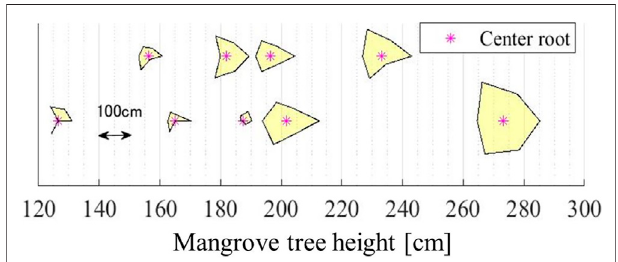
images of mangrove roots using a digital camera (Olympus TG-6, 4,000 × 3,000 pixels) along with a whiteboard as the background ( Figure 1 ). The 2D images were taken in two different directions in two major axes of the root system, and no image correction was applied due to the dif fi culty of the detail of calibration in the fi eld.